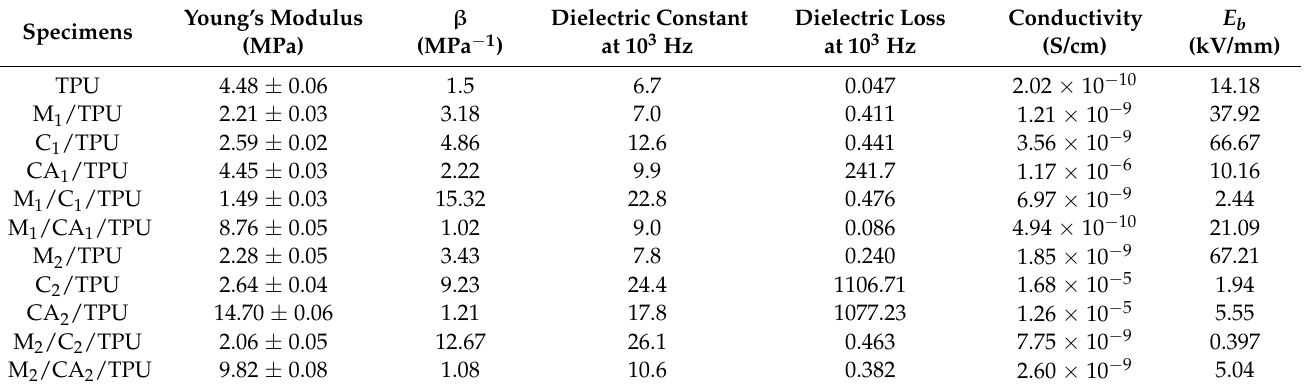
Figure 11. Schematic diagram of surface functional group reaction of CNTs/MXene/TPU composite. Table 1. Dielectric and mechanical properties of TPU